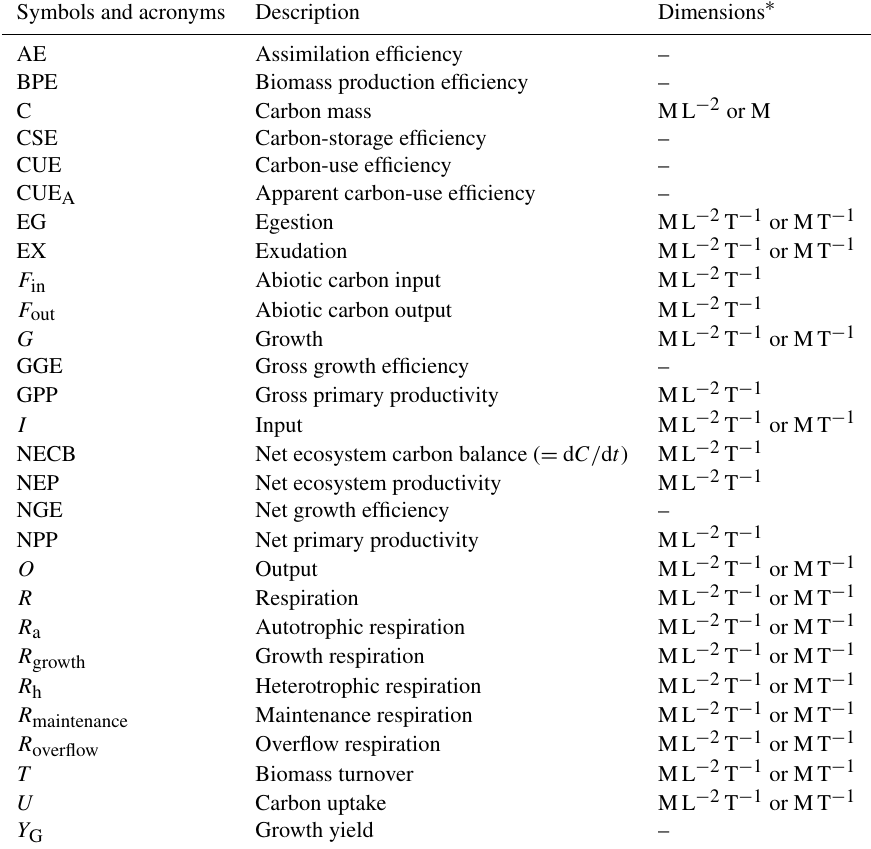
Table 1. Definition of symbols and